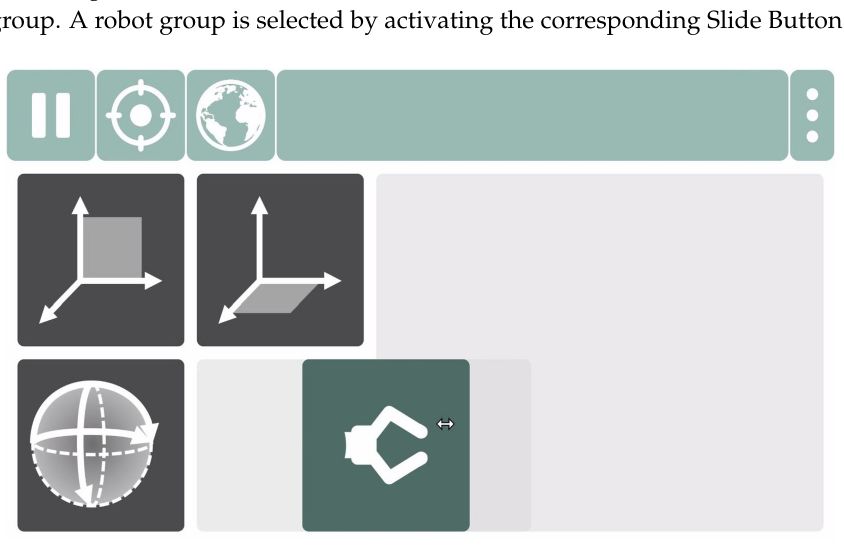
Figure 7. Graphical User Interface during Cursor Control Mode. The GUI contains one Slide Button for each robot group. The dwell buttons in the top toolbar allow the user to perform several actions, such as pausing control, starting calibration routines or exiting the